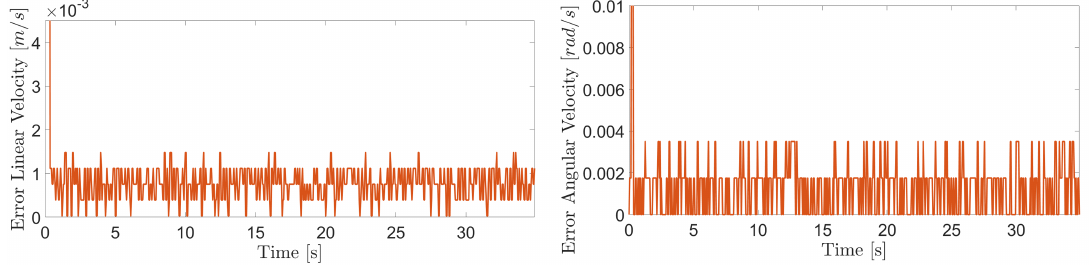
Figure 21. Linear and angular velocity errors during navigation of the climbing robot at 0 degree inclination.